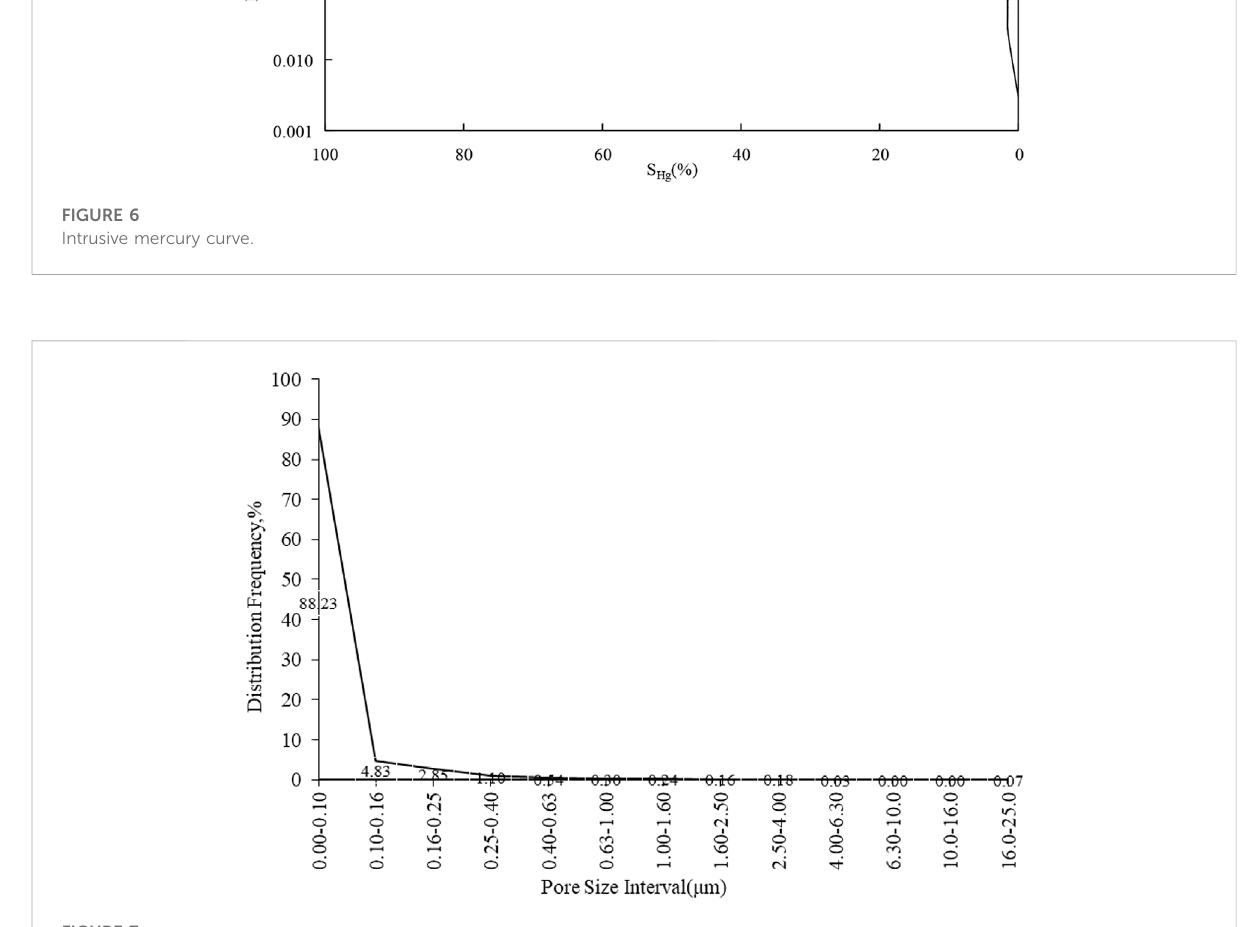
Pore-throat distribution